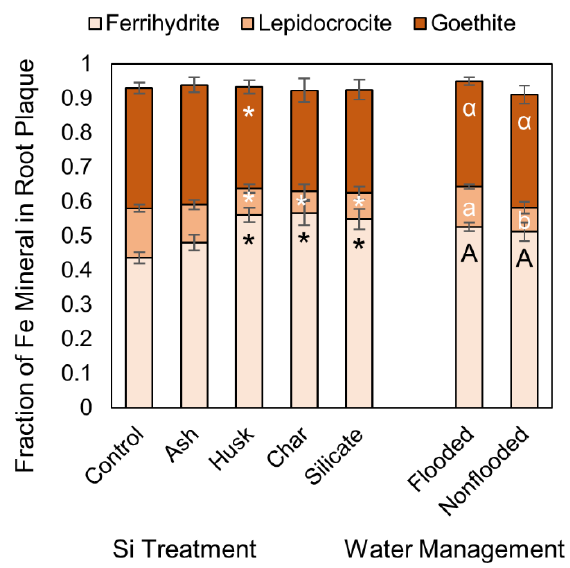
Figure 2. The proportion of major Fe (hydr)oxide mineral phases that comprise Fe plaque on rice roots is affected by both soil Si amendment and water management. For experiments where soil Si was manipulated, asterisks indicate treatments significantly different from the Control for each mineral at the 0.05 level. For experiments where water was manipulated, bars with the same letters are not significantly different at the 0.05 level. Error bars denote the standard error (Control: n = 38; Ash: n = 17; Husk: n = 26; Char: n = 9; Silicate: n = 12; Flooded: n = 87; Nonflooded: n = 15).